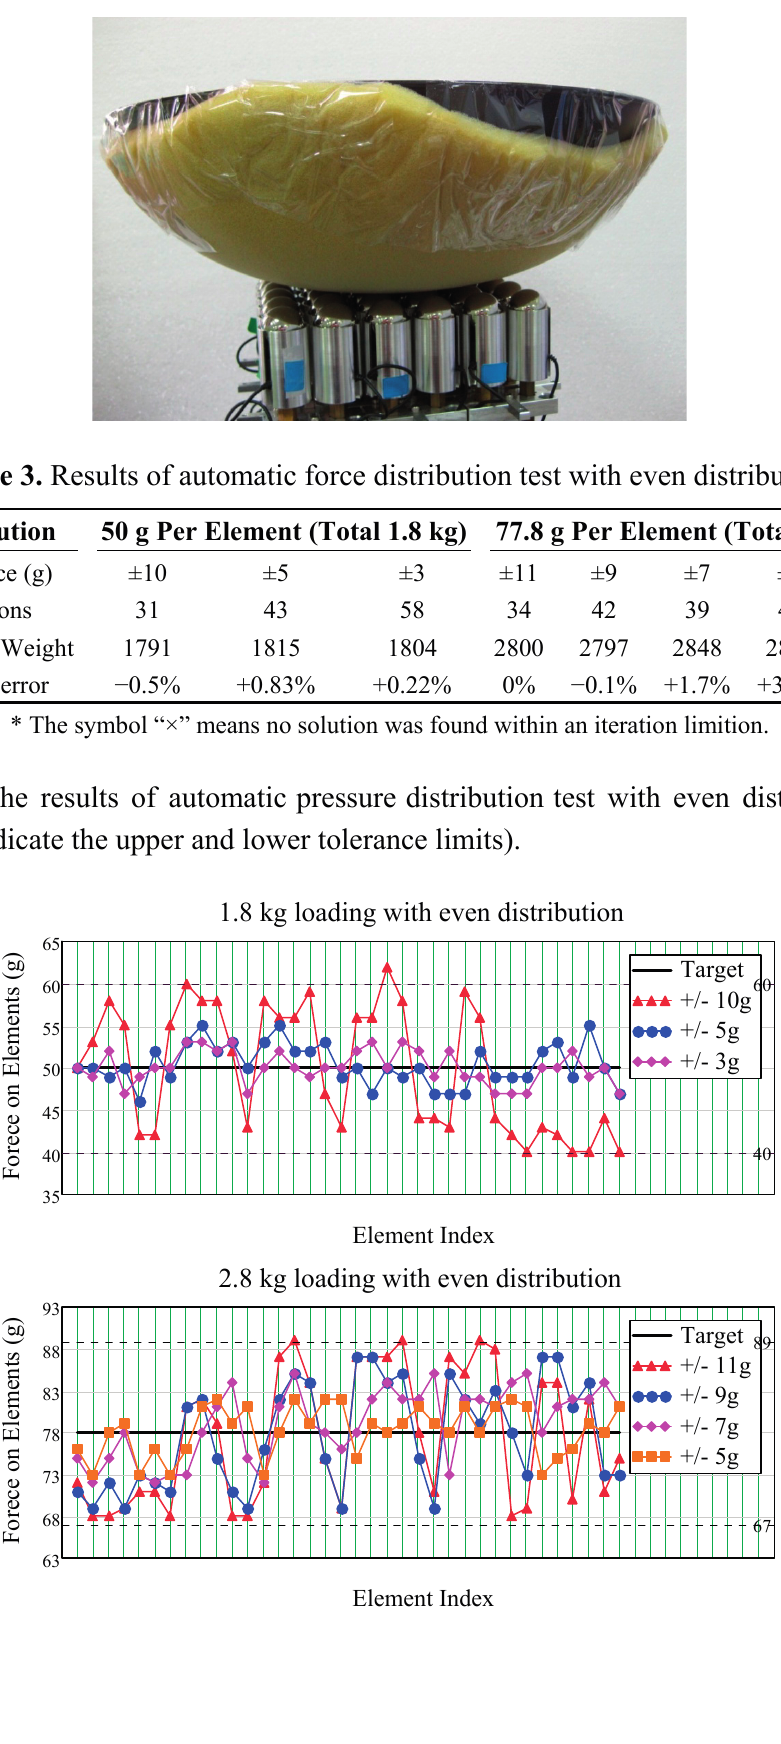
Figure 9. Setup for automatic pressure distribution test.